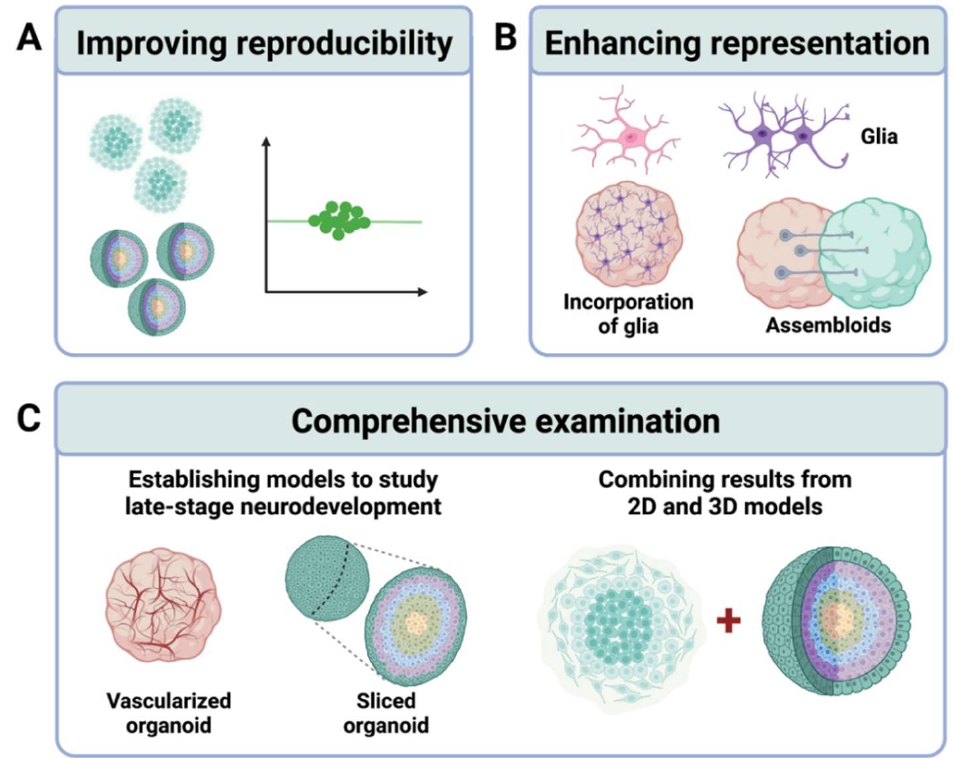
Figure 3. Summary of future directions for FXS-iPSC research. Future studies of human iPSC- based models of FXS should aim to ( A ) improve reproducibility, ( B ) enhance the representation of neural network structure and organization through the incorporation of various glial cell types and use of assembloids, and ( C ) provide a comprehensive examination of neurodevelopment from early to late stages by developing models that allow for prolonged culture, such as vascularized and sliced organoid models, as well as by corroborating results through a combination of 2D and 3D models.